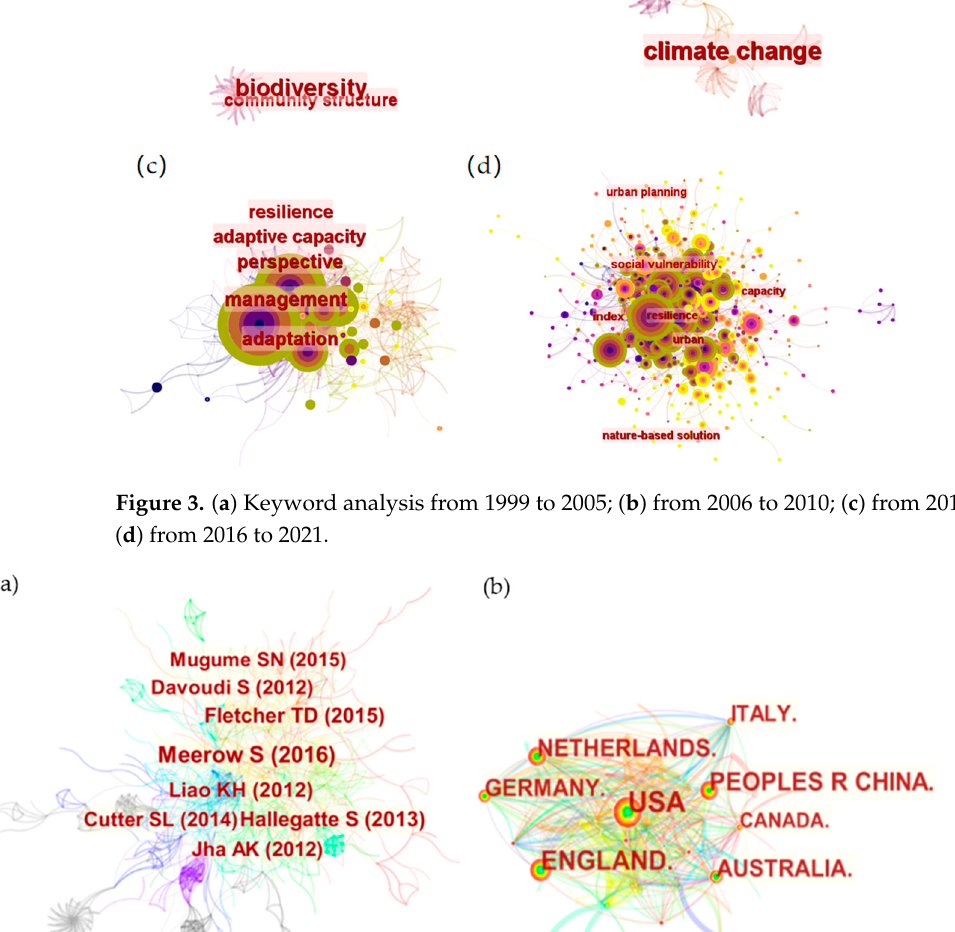
Figure 3. ( a ) Keyword analysis from 1999 to 2005; ( b ) from 2006 to 2010; ( c ) from 2011 to 2015; and ( d ) from 2016 to 2021.